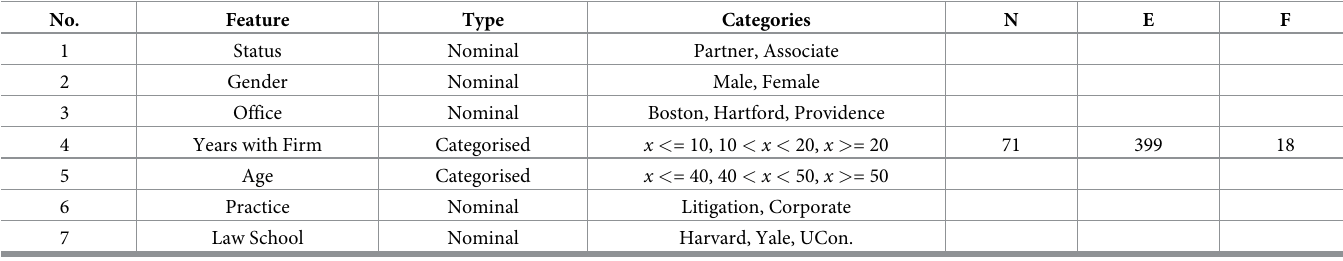
Table 2. Features in the Lawyers